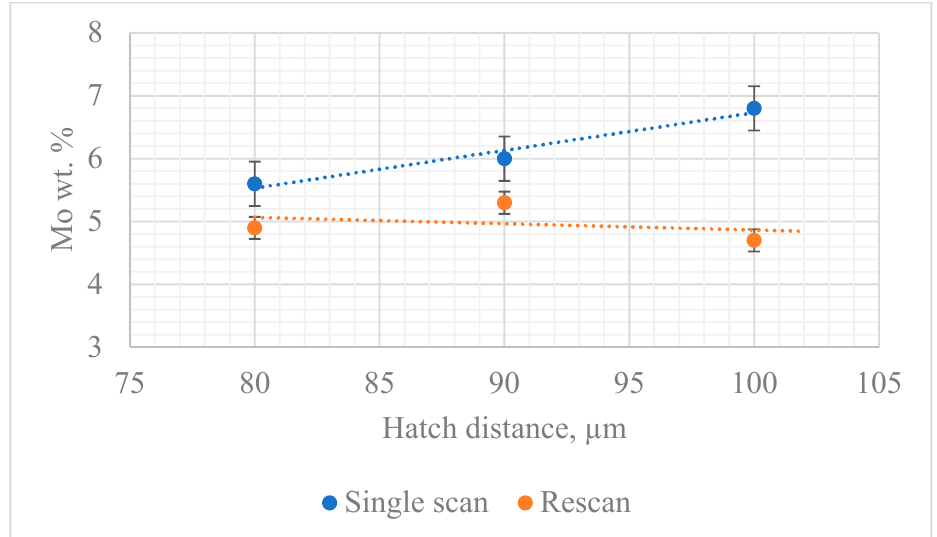
Figure 7. Average Wt.% distribution of Mo in the Ti5Mo alloy matrix at different hatch distances.